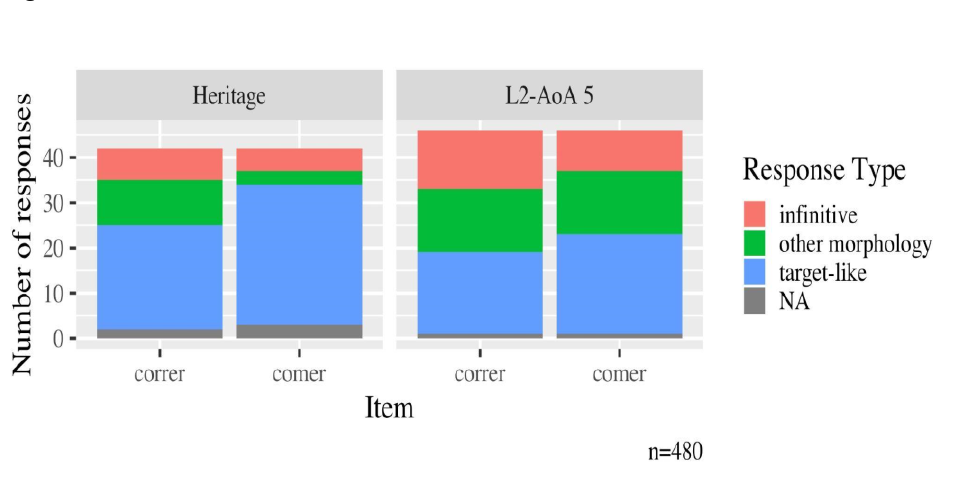
Figure 3. Types of non-target-like responses by group and lexical